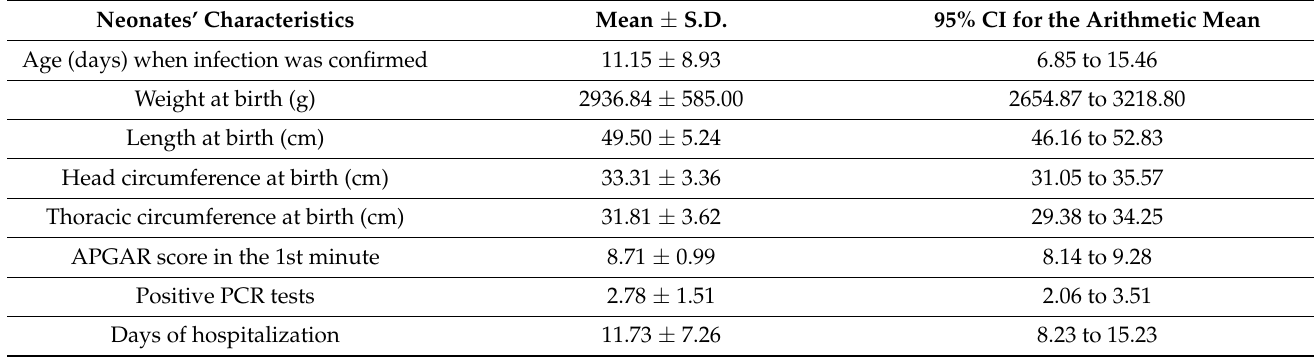
Table 2. The baseline characteristics of infected neonates presented as mean ± S.D and 95% CI for the arithmetic